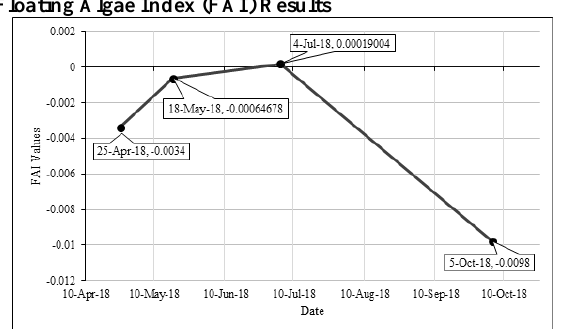
Figure 9. Floating Algae Index trend from April 25 to Oct 5.